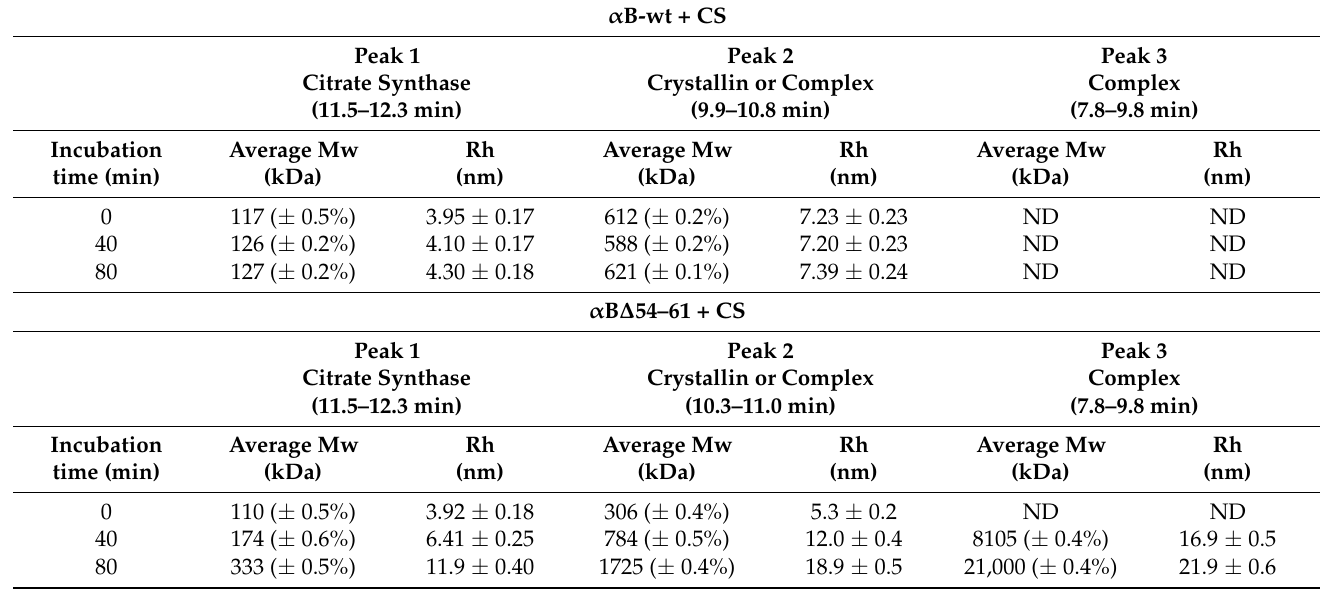
Table 1. MALS analysis of chaperone protein and CS incubation